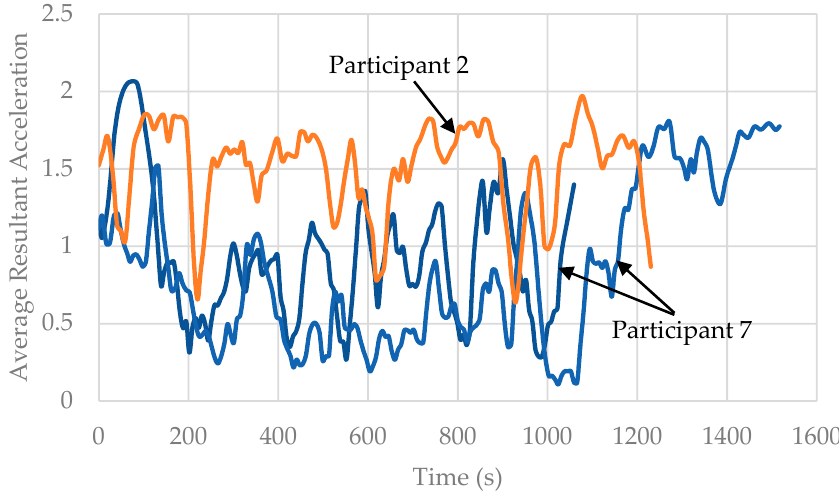
Figure 9. Information sharing at participant level.